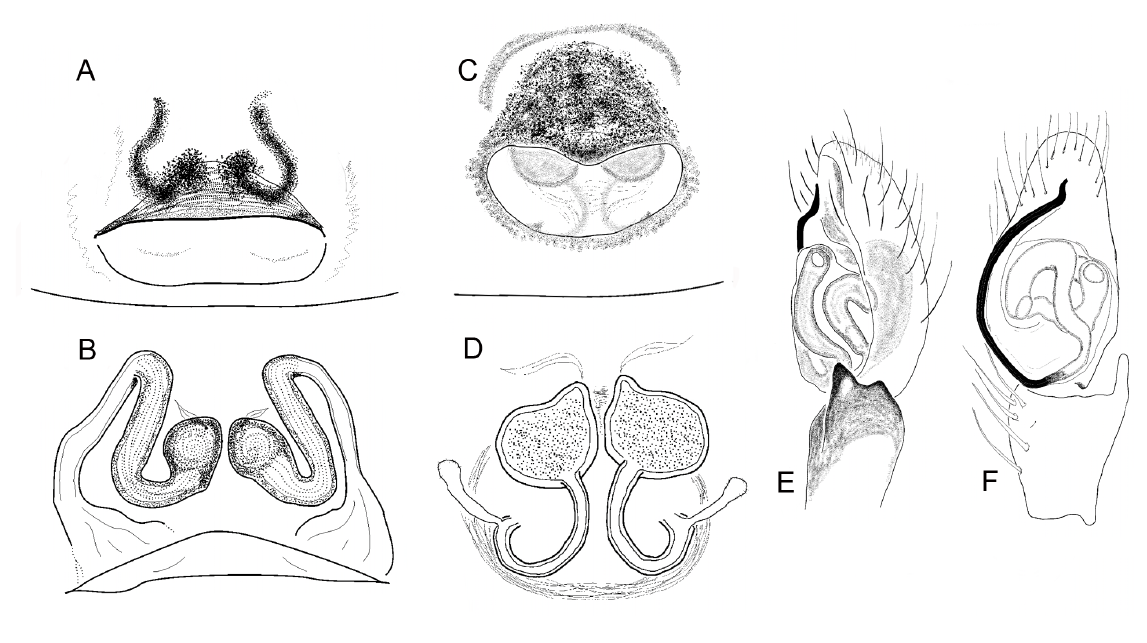
Fig. 5. Genitalia of Synemosyna spp. A–B . S. myrmeciaeformis (Taczanowski, 1871). A .